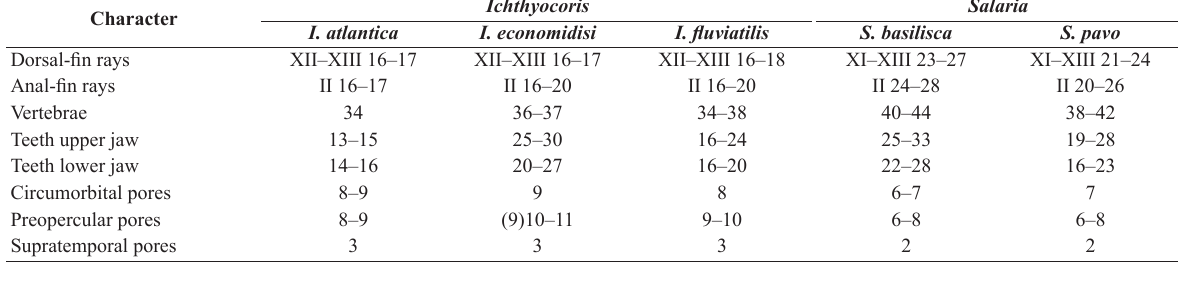
Table 1. Meristic characters characterizing Ichthyocoris and Salaria species.